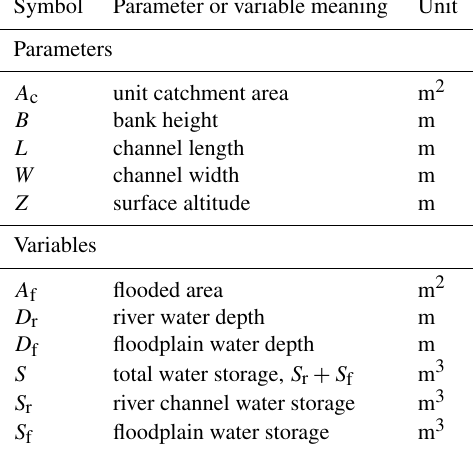
Table 1. CaMa-Flood subgrid parameters in Fig. 1 (based from Ya- mazaki et al.,